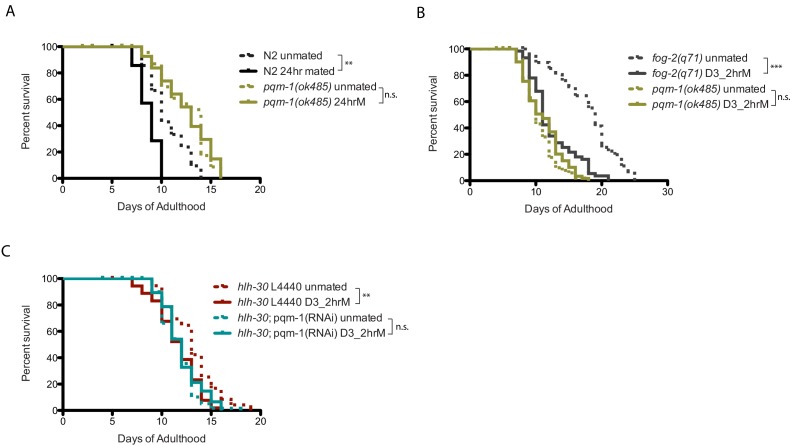
PQM-1 is required for SF killing.(A–B) pqm-1 mutants are resistant to both long-term (24 hr; B) and brief (2 hr) mating (C). (C) Knocking down hlh-30 in pqm-1 mutants does not make them susceptible to brief mating-induced death. hlh-30 on vector control RNAi: unmated:13.1 ± 0.4 days, mated: 11.6 ± 0.3 days, p=0.0015. hlh-30 on pqm-1 RNAi:unmated:11.7 ± 0.2 days, mated: 12.0 ± 0.2 days, p=0.3601.